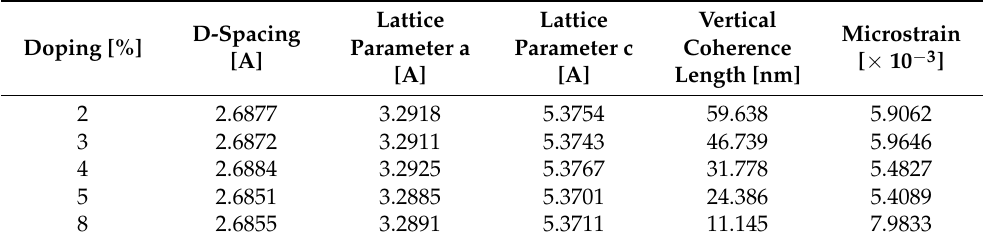
Figure 4. ( a ) θ –2 θ X-ray diffraction patterns of the AZO films, in accordance with [PDF 00-036-1451]. ( b ) Vertical coherence length and microstrain in the function of Al-doping (at.%). Table 2. Extracted values of the d-spacing, lattice parameter a, lattice parameter c, vertical coherence length, and microstrain as a function of the doping concentration.